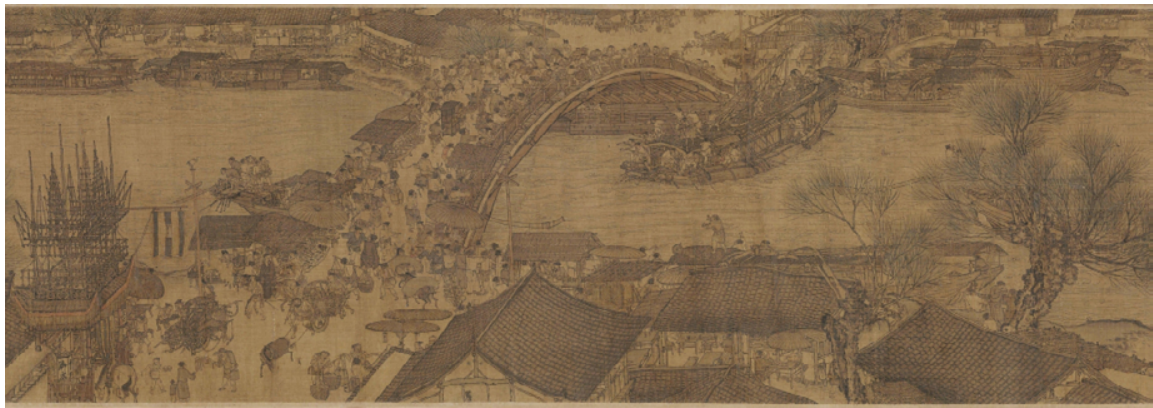
Fragment of the classic painting Qingming Shang He Tu – original painting by Zhang Zeduan. Twelfth century, Handscroll, 24.8 x 528.7 cm (Source: Beijing, Palace